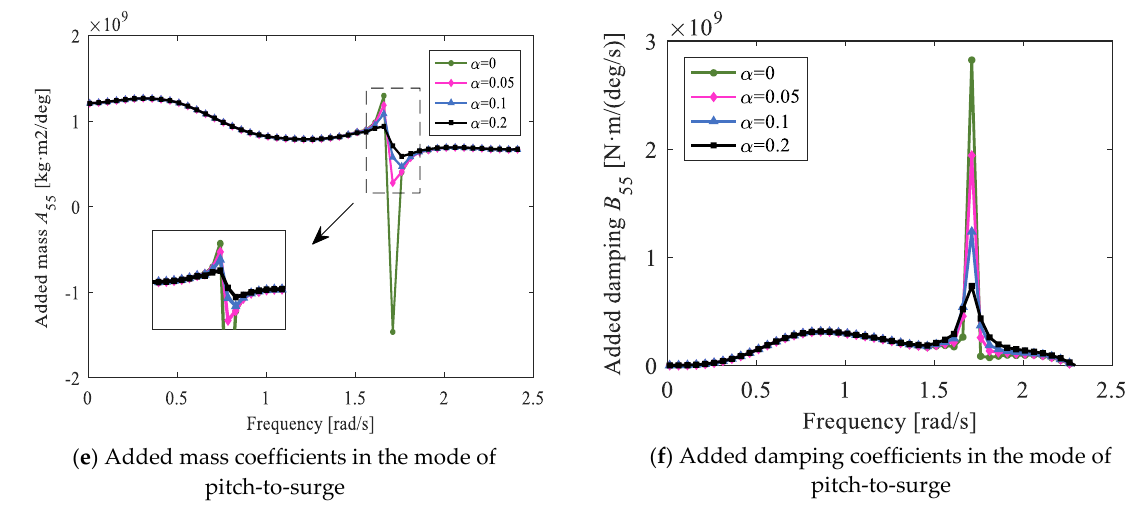
 , in 3- module model.